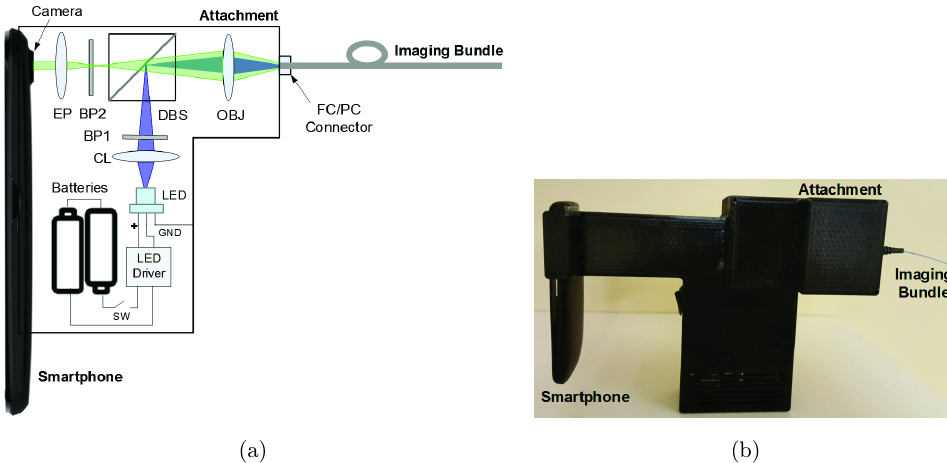
Fig. 1. The smartphone microendoscope system: (a) schematic diagram and (b) photograph of the ¯rst prototype. (EP – eyepiece; BP1 & BP2 – optical bandpass ¯lters; DBS — dichroic beamsplitter; OBJ – microscope objective; CL – condenser lens; LED – light emitting diode; GND – ground; SW – ON/OFF